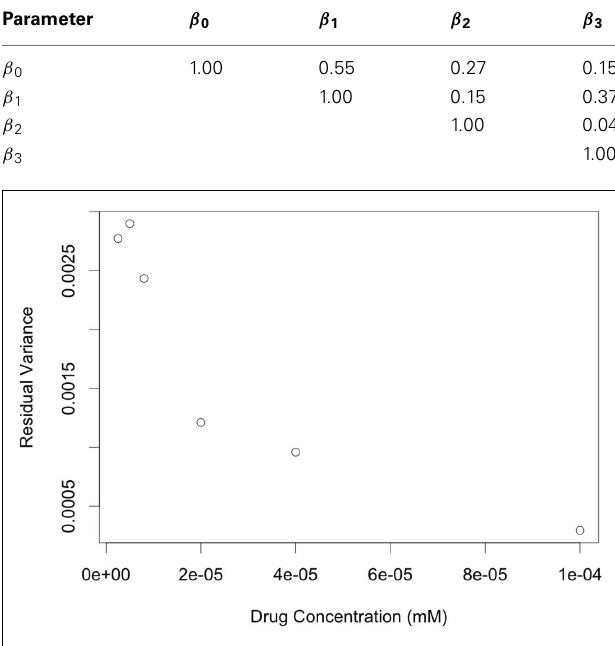
FIGURE 9 | Plots of residual variance vs. concentration for dose-response data of LCLs exposed to Gemcitabine and fit with a hill slope